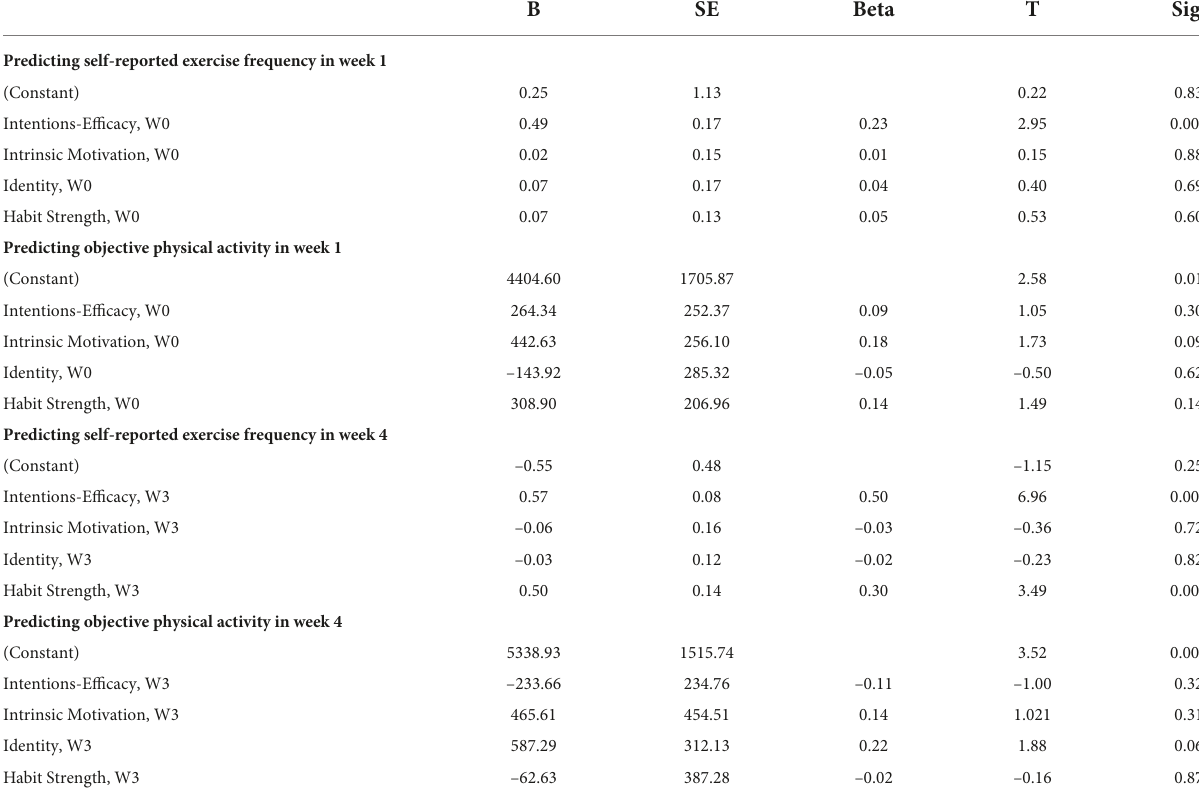
TABLE 2B Regression results for exercise variables (weeks 1 and 4 outcomes only, for comparison and space reasons). B SE Beta T